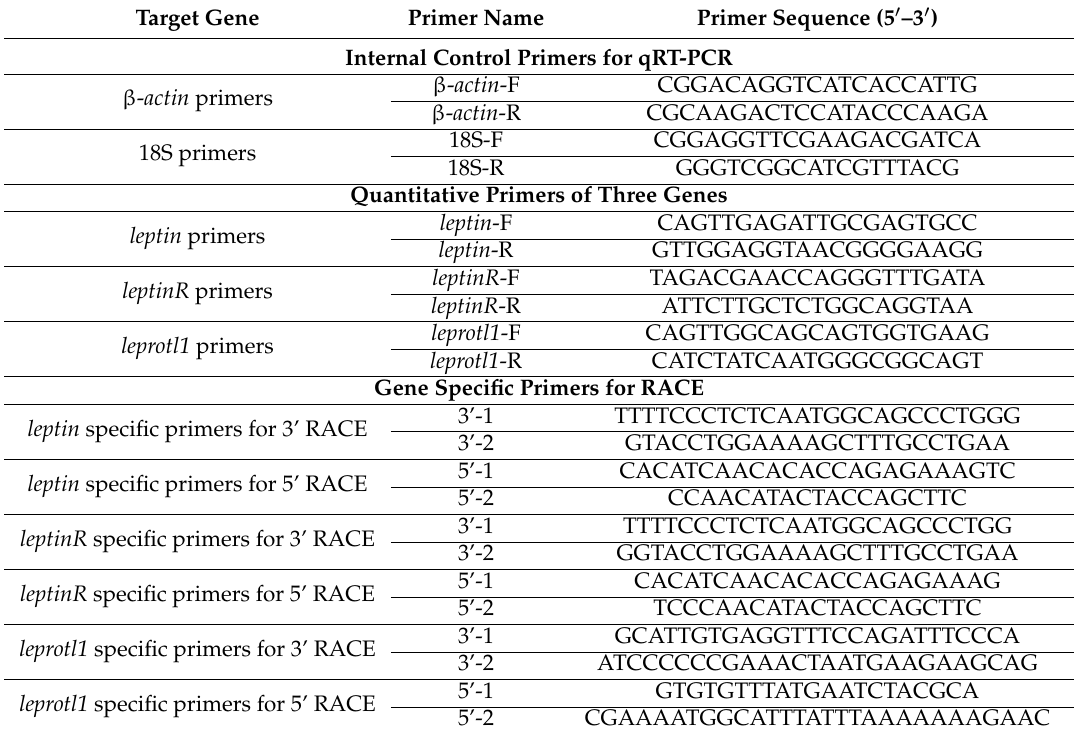
Table 3. The primer sequences for genes cloning and expression in the